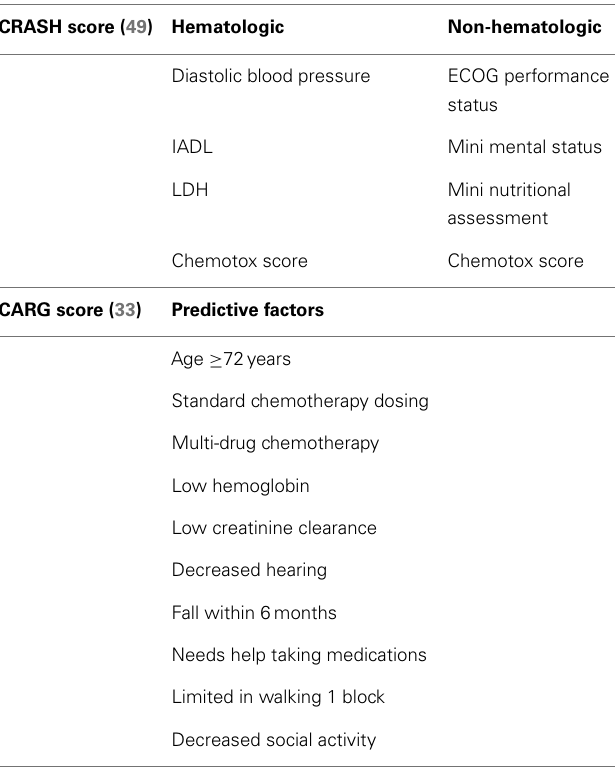
Table 2 | Significant factors in scores predicting chemotherapy toxicity